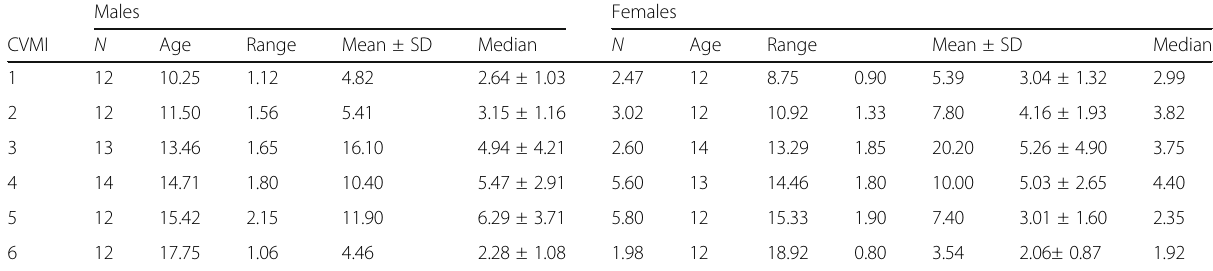
Table 2 Osteocalcin (ng/ml) descriptive statistics for each CVMI stage in males and females Males Females CVMI